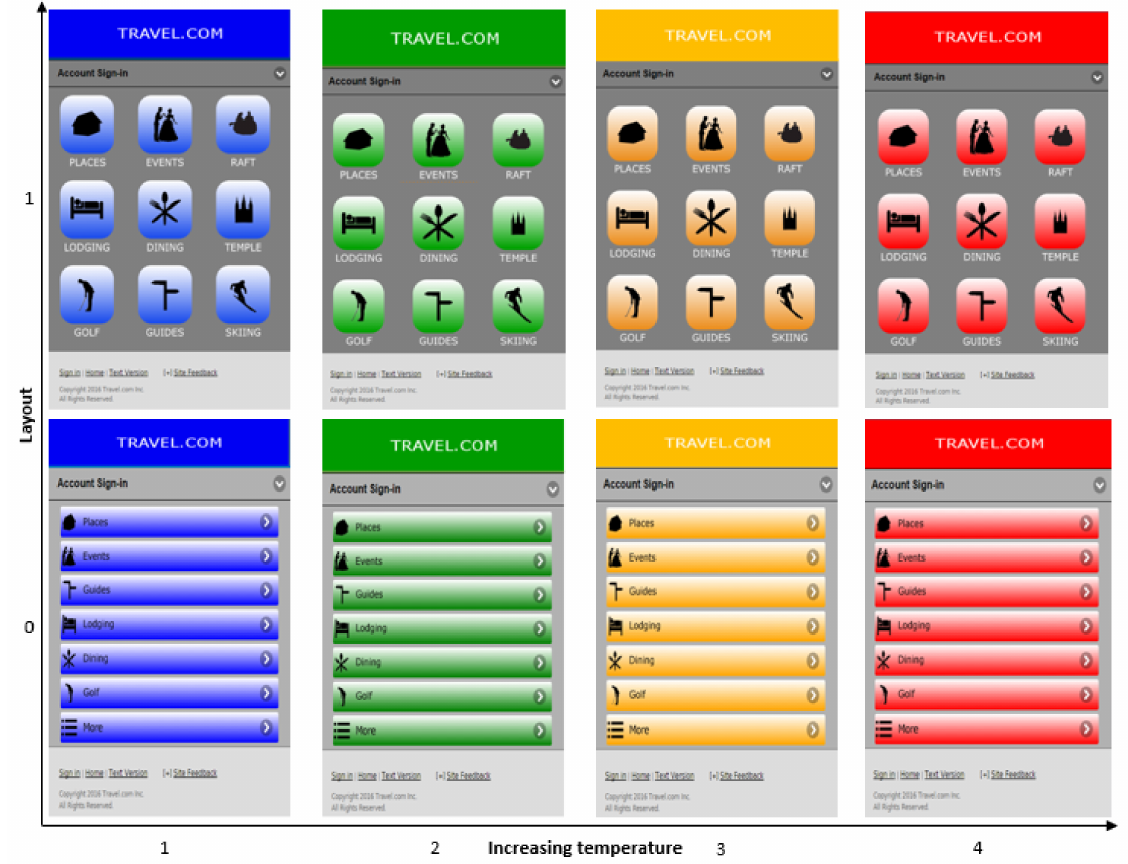
Figure 1. Eight versions of a mobile website starting from the coldest temperature (blue) to the warmest temperature (red). The layout and colour temperatures are coded accordingly to allow us conduct a PLSPM analysis, which requires ordinal data.